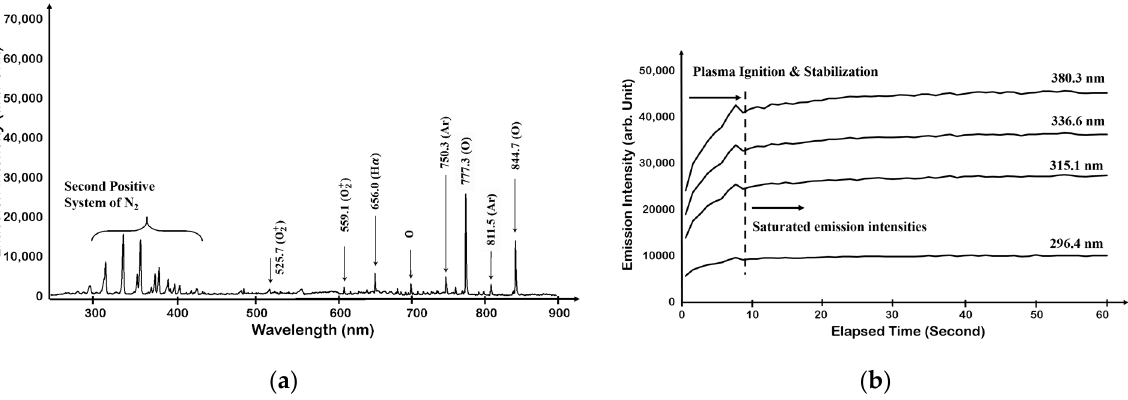
Figure 2. Optical emission spectrum of oxygen: ( a ) oxygen plasma and ( b ) change in O 2 plasma intensity over time [27,28].